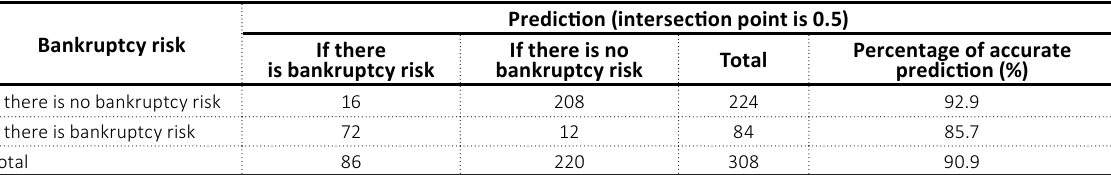
Table 7. Testing the predictive power of the